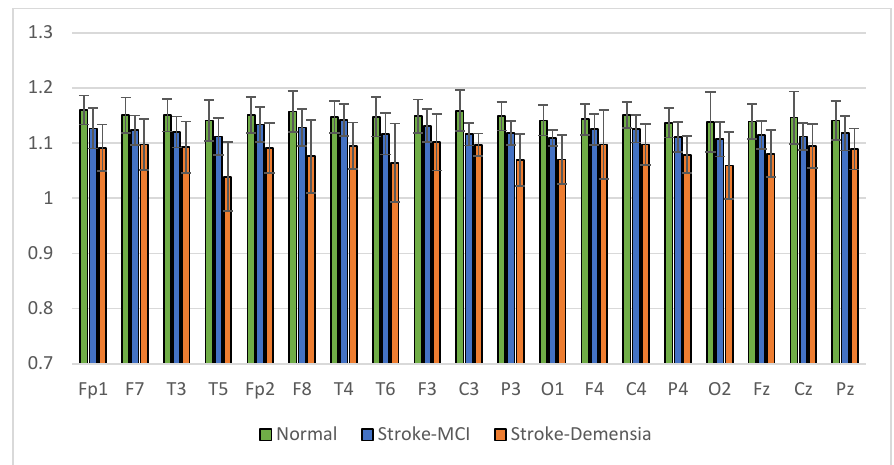
Figure 17. Mean of the SpecEn values of the normal, post-stroke MCI, and dementia.